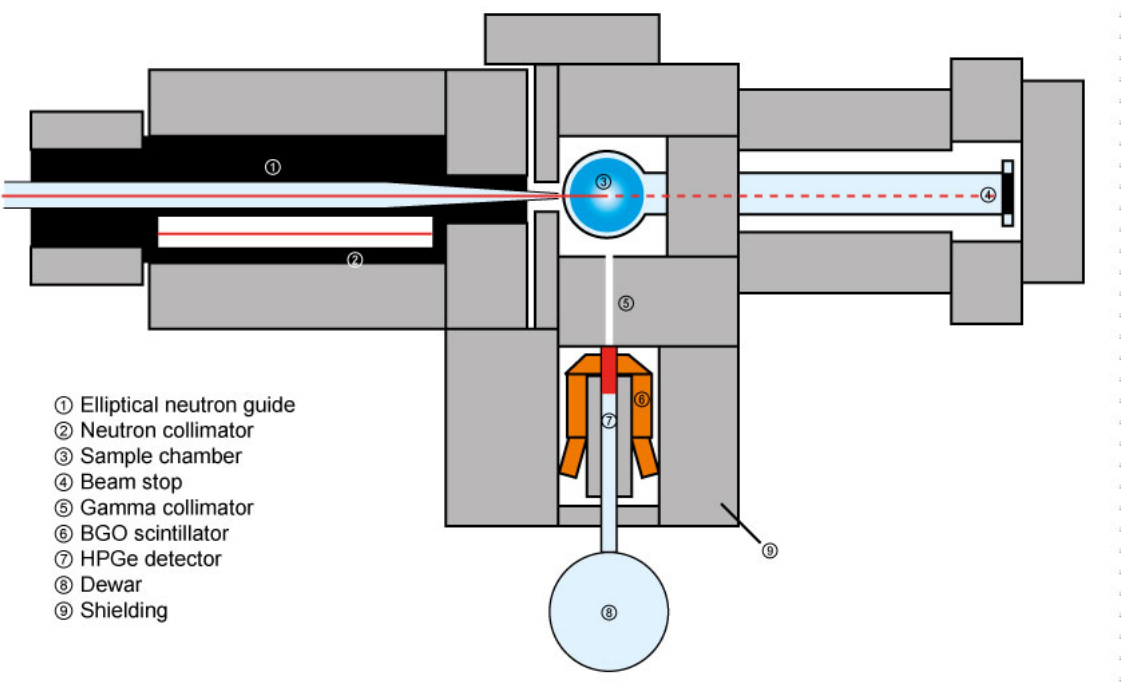
Figure 2: The shielding arrangement of the PGAA